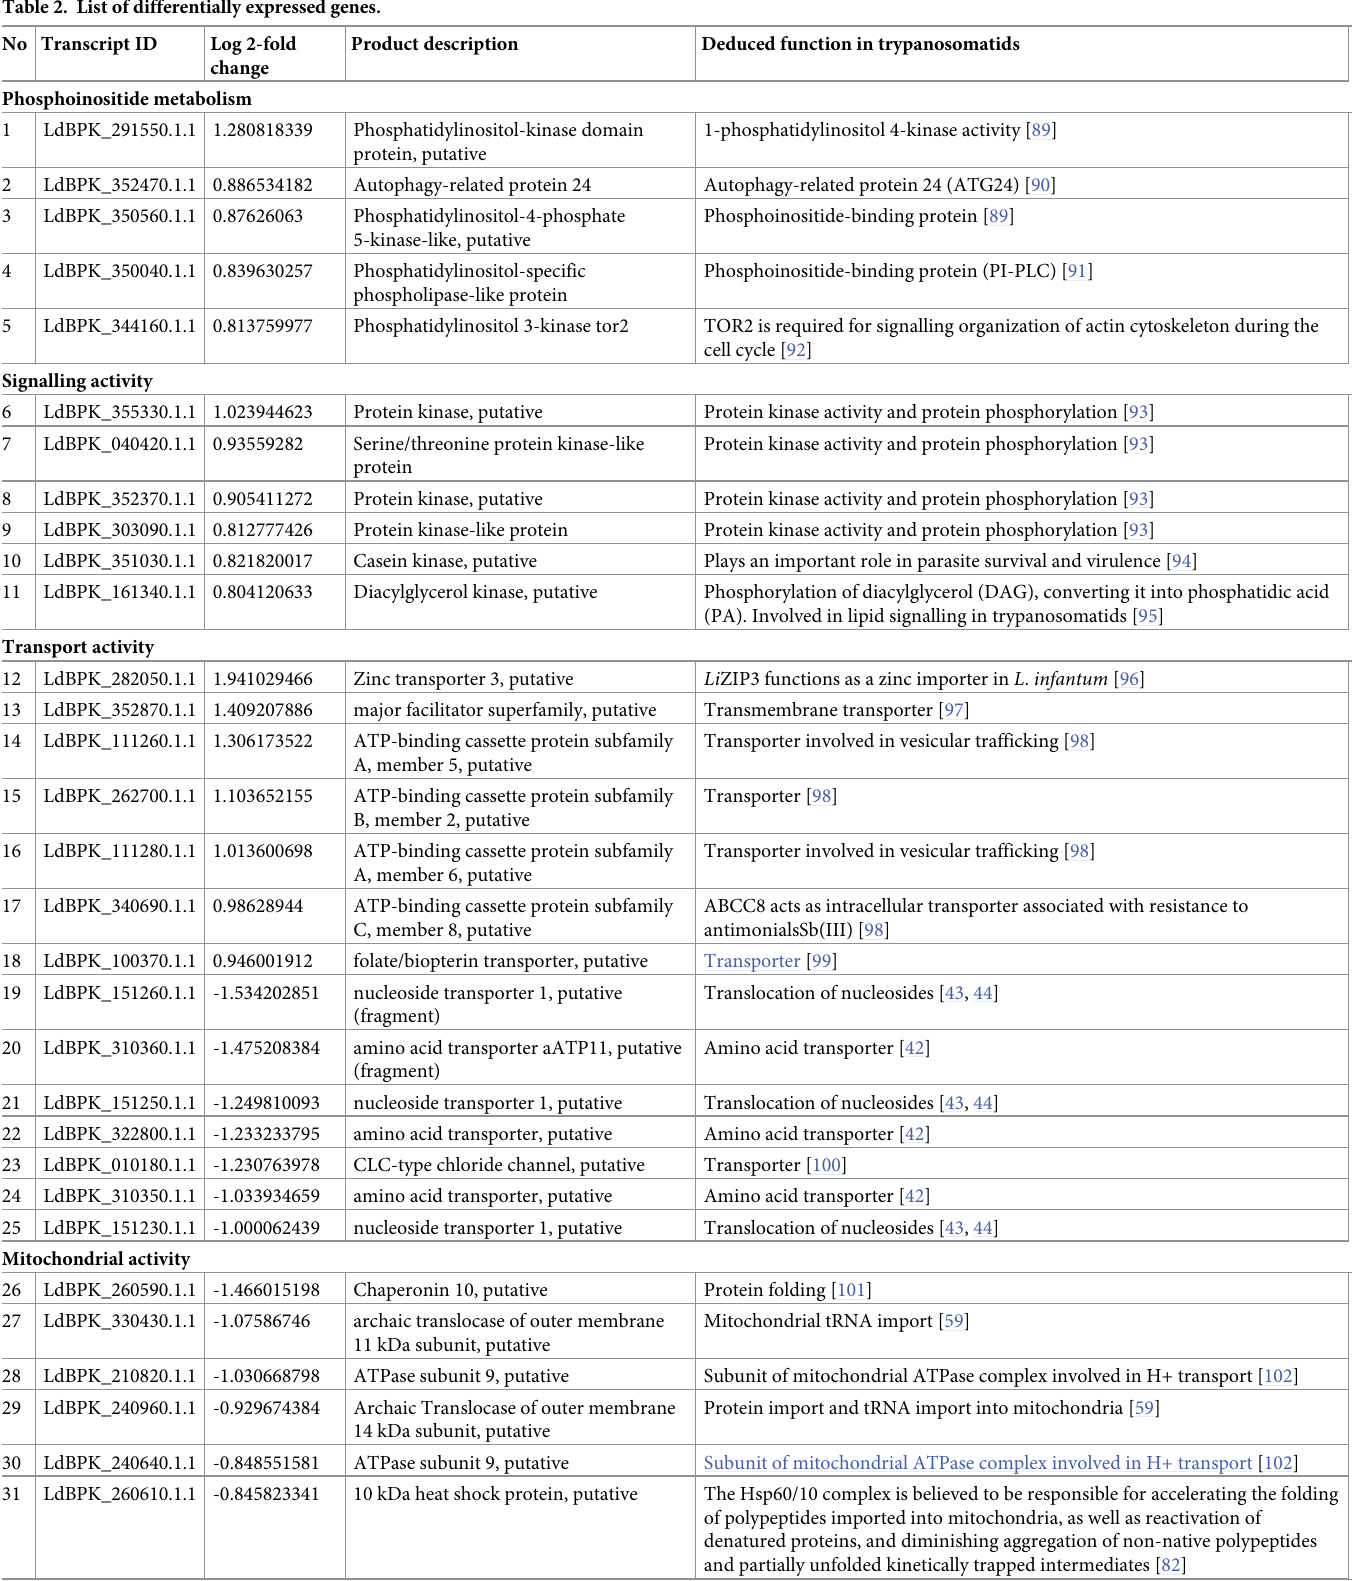
Table 2. List of differentially expressed